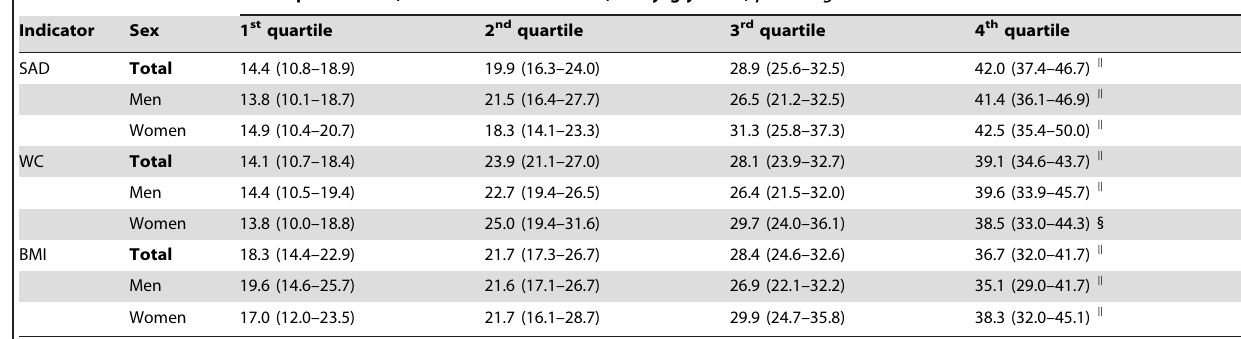
Table 3. Crude prevalence (%) of dysglycemia by quartiles of adiposity indicators in US adults ages $ 20 years without diagnosed diabetes, estimated from NHANES